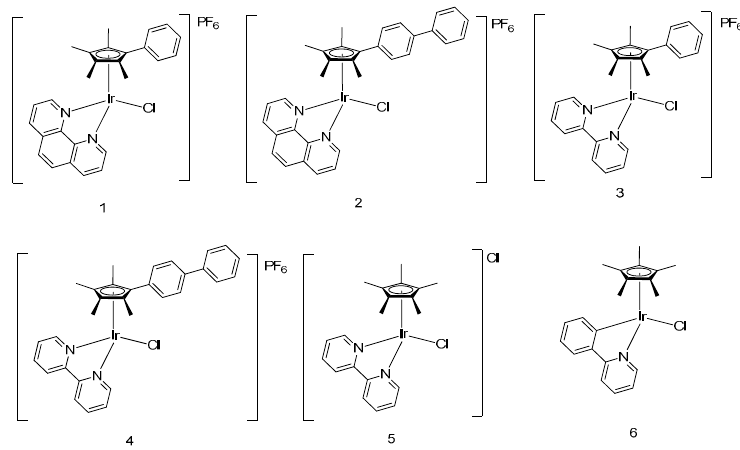
Figure 1. Organometallic half-sandwich iridium(III) compounds with different arene and bidentate groups.